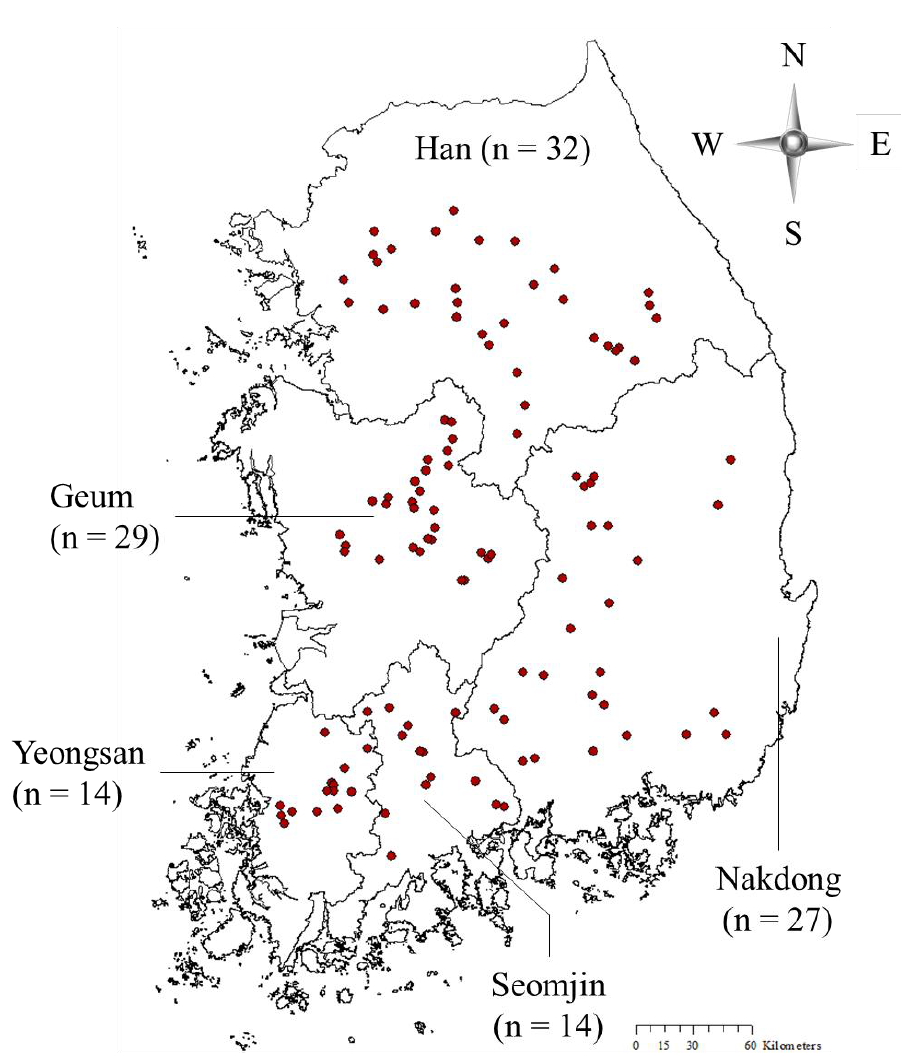
Figure 1. Study sites (a total of 115) in the five major watersheds (Han, Nakdong, Geum, Seomjin, and Yeongsan rivers) of South Korea for the present study.